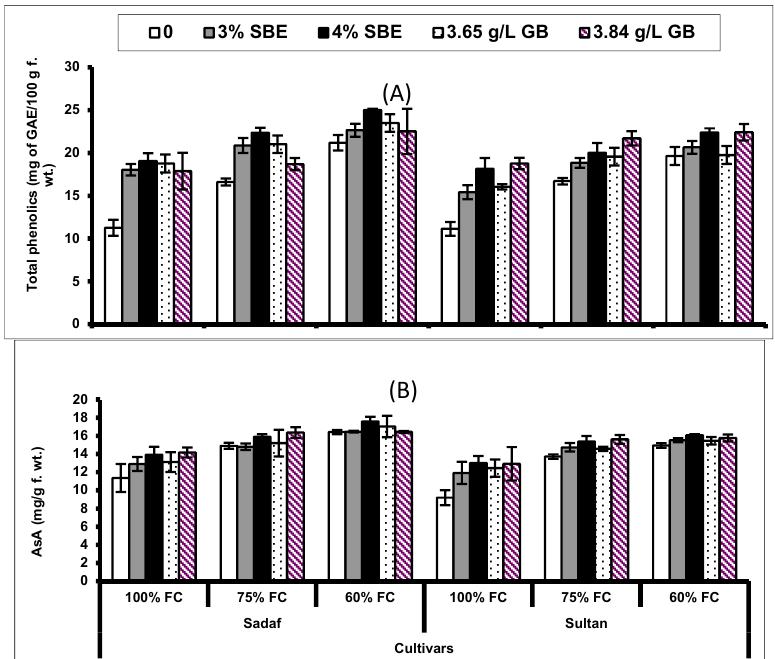
Figure 4. ( A ) Total phenolics and ( B ) ascorbic acid (AsA) of two maize cultivars foliar-fed with vary- ing levels of sugar beet extract (SBE) and glycine betaine under water deficit conditions (Mean ± S.E.).